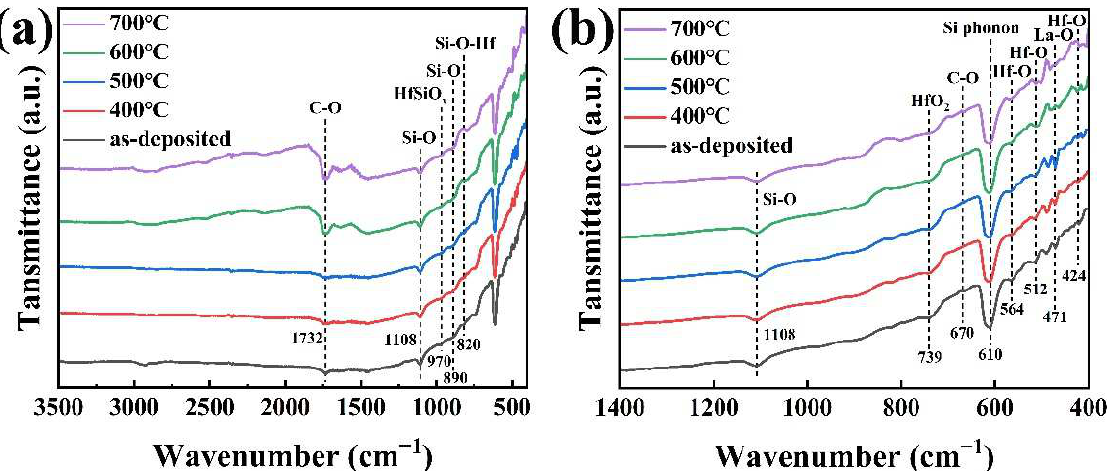
Figure 2. ( a ) FTIR spectra of lanthanum-doped HfO 2 films at different temperatures; ( b ) FTIR spectrum of 400–1400 cm −1 interval.